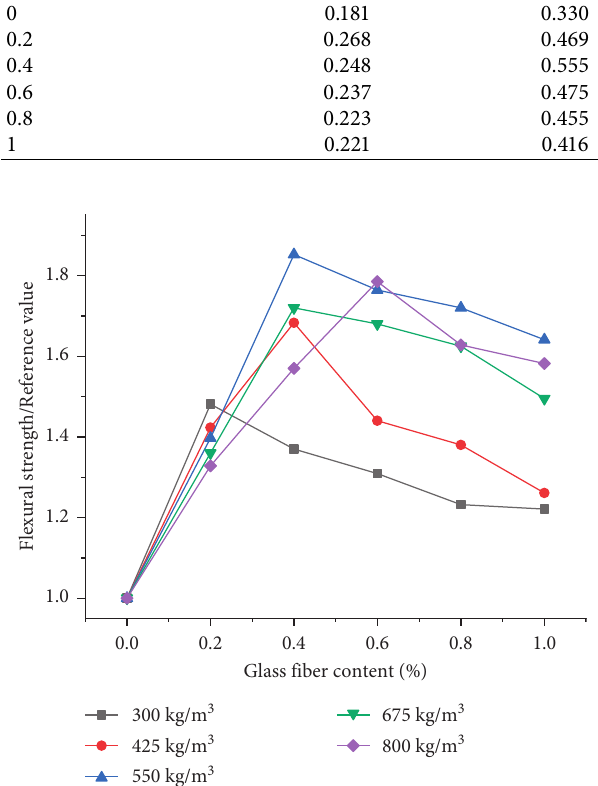
Figure 16: The change of flexural strength with fiber content.